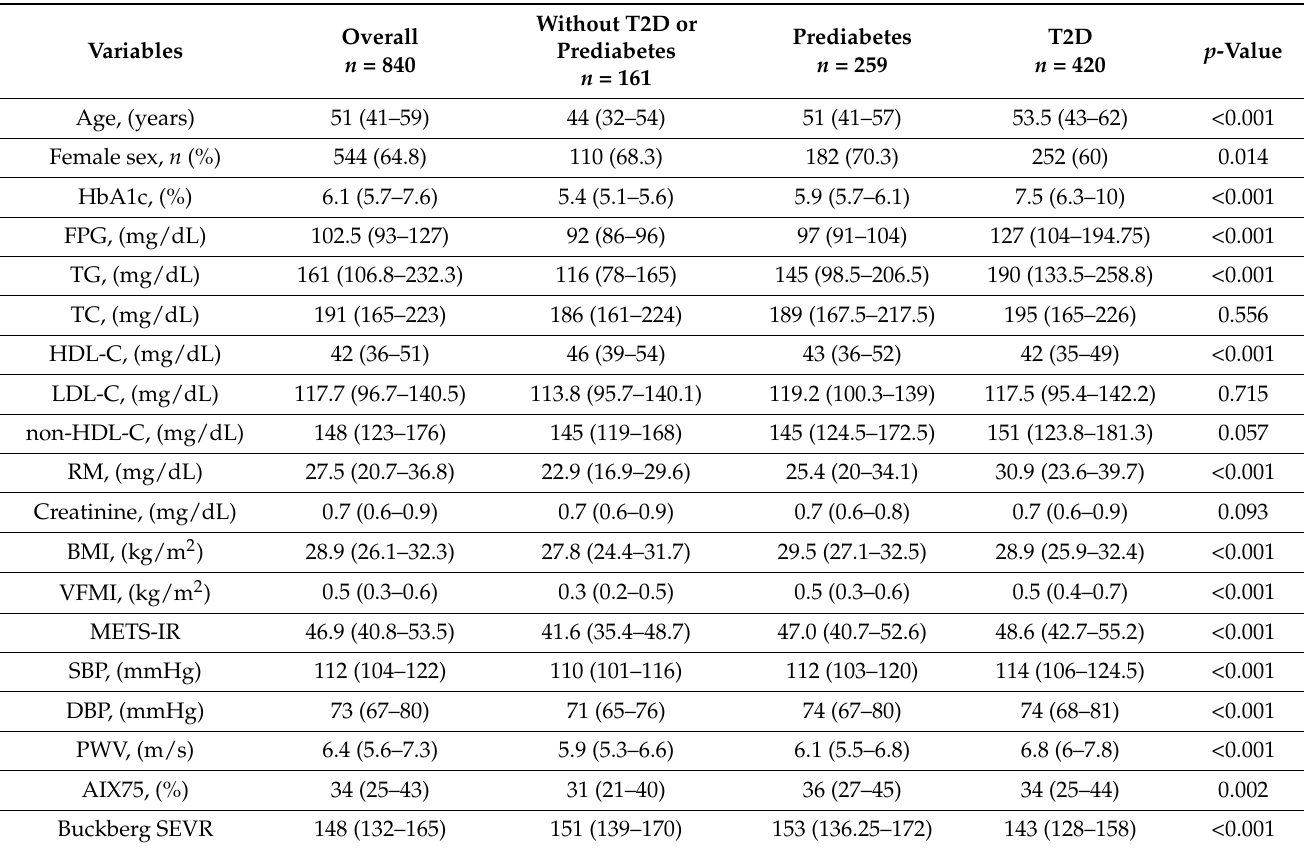
Table 1. Population demographic characteristics, laboratory data, and pulse-waveform analysis measurements in Hispanic